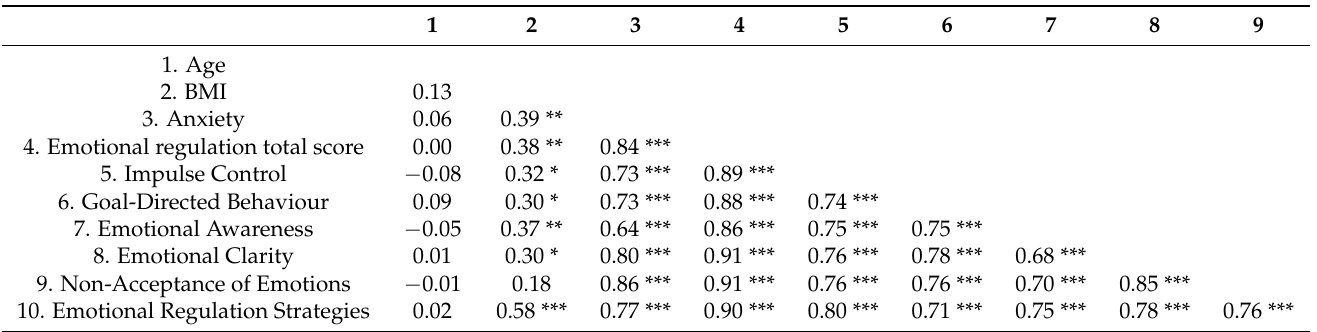
Table 2. Pearson’s Product Moment Correlations Between Demographics, Anxiety, and Emo- tional